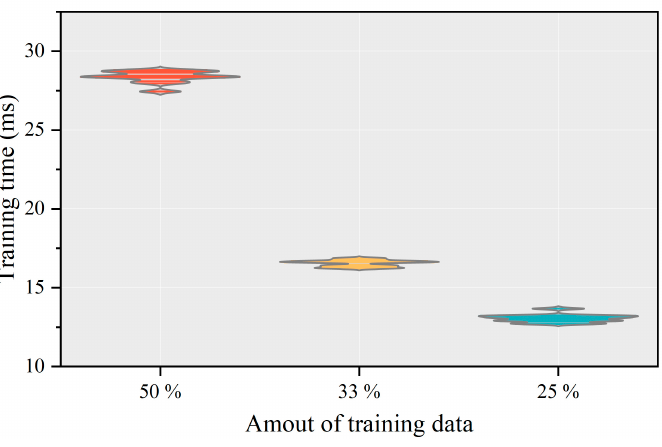
Figure 10. The training time of different amounts of training data on the model.